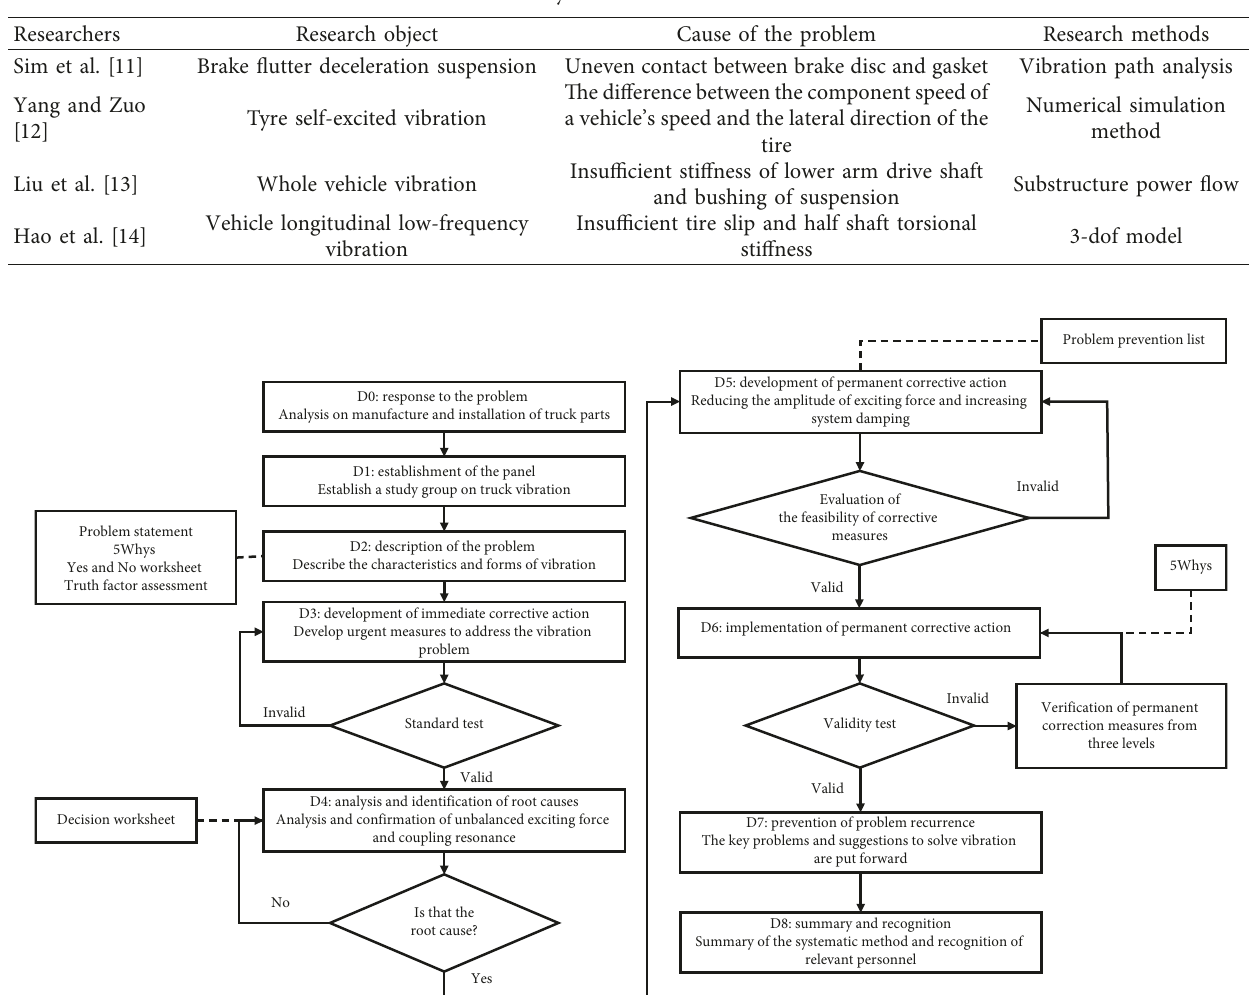
Table 1: Summary of research on vehicle vibration.